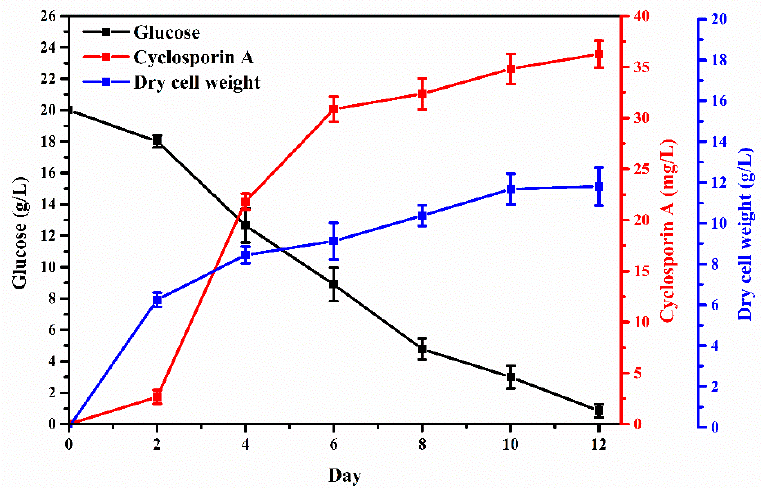
Figure 4. Fermentation profiling of Tolypocladium inflatum ATCC 34921 for cyclosporin A production in the main medium (carbon source: 2% ( w / v ) commercial glucose).